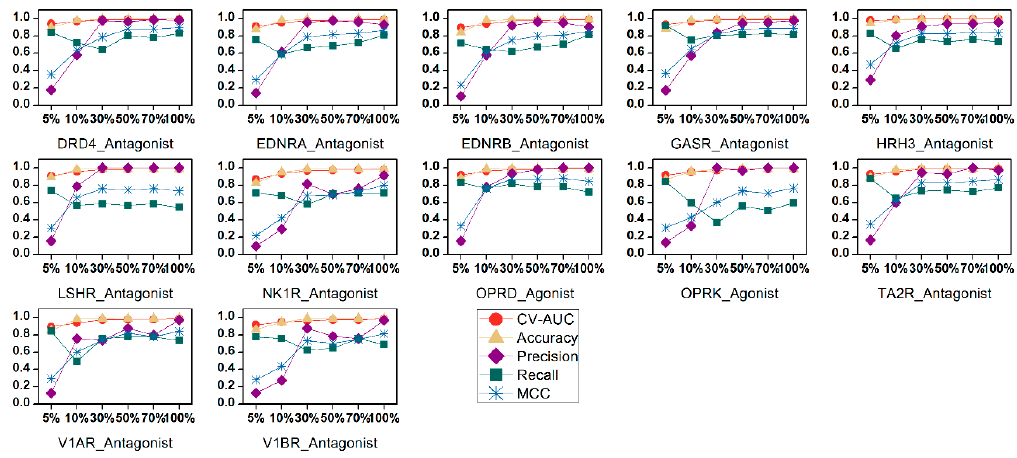
Figure 3. Comparison of SVM models using different BRS-3D feature subsets. For most data sets, the prediction performances were improved with the increasing of feature numbers.